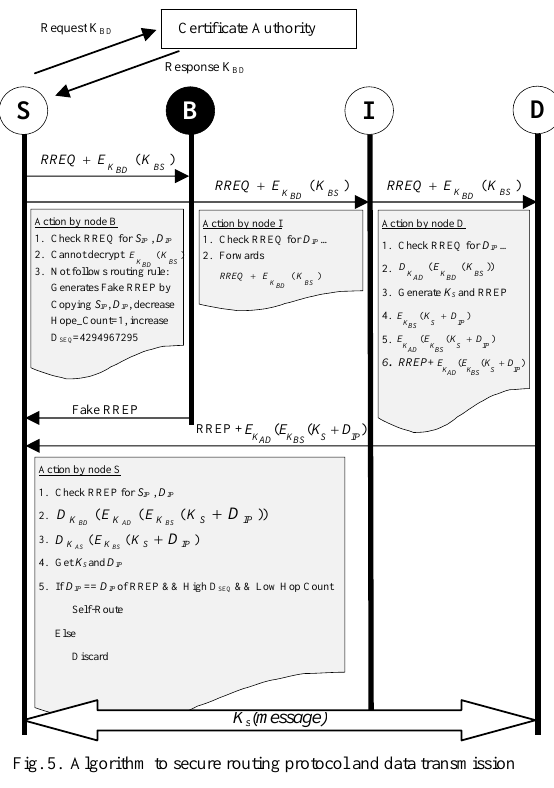
Fig. 5. Algorithm to secure routing protocol and data